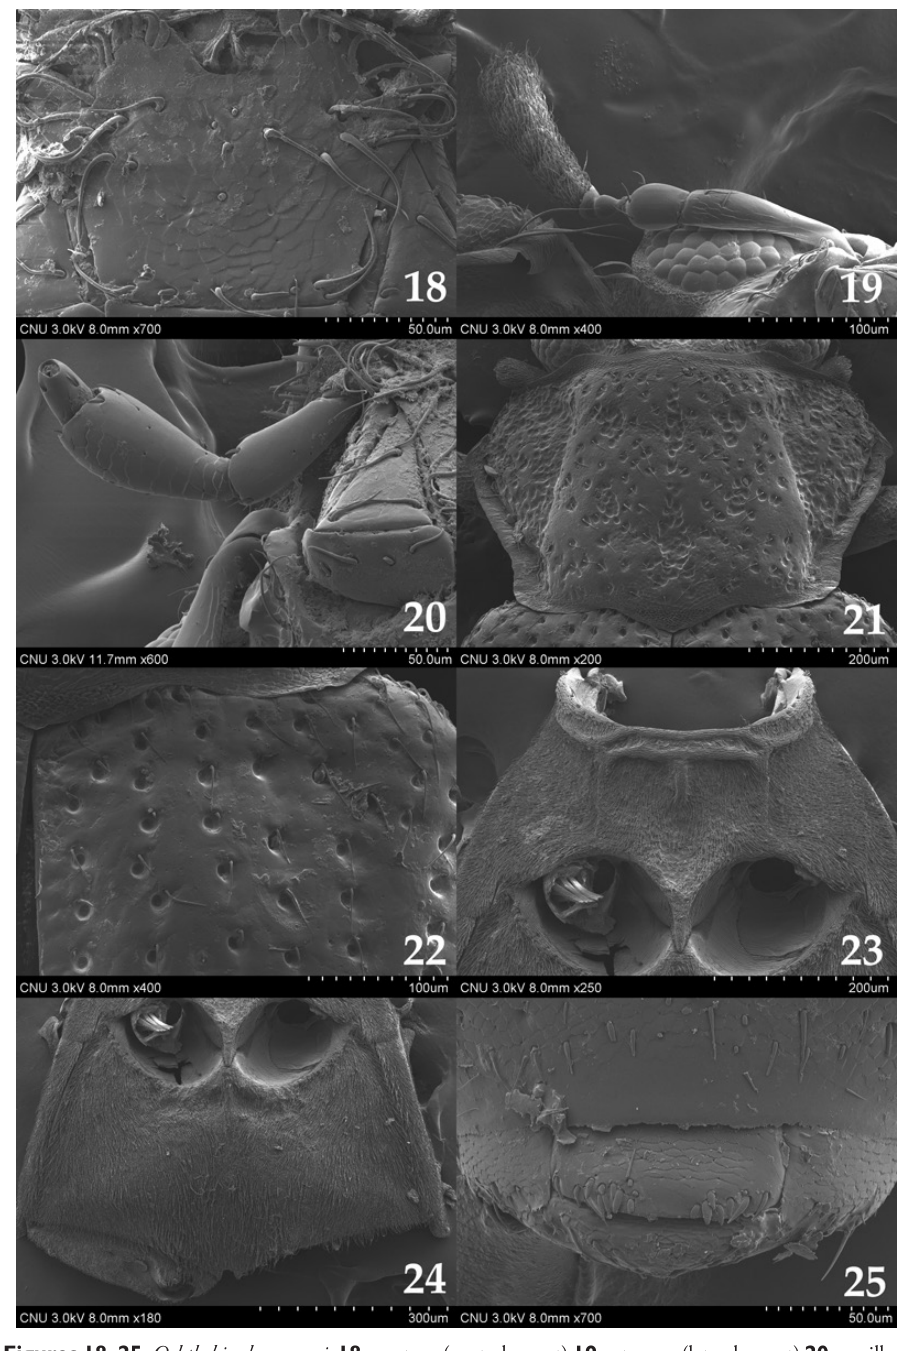
Figures 18–25. Ochthebius hasegawai . 18 mentum (ventral aspect) 19 antennae (lateral aspect) 20 maxillary palpus (ventral aspect) 21 pronotum (dorsal aspect) 22 anterior part of elytron (dorsal aspect) 23 mesoven- trite (ventral aspect) 24 metaventrite (ventral aspect) 25 male terminal sternite (ventral